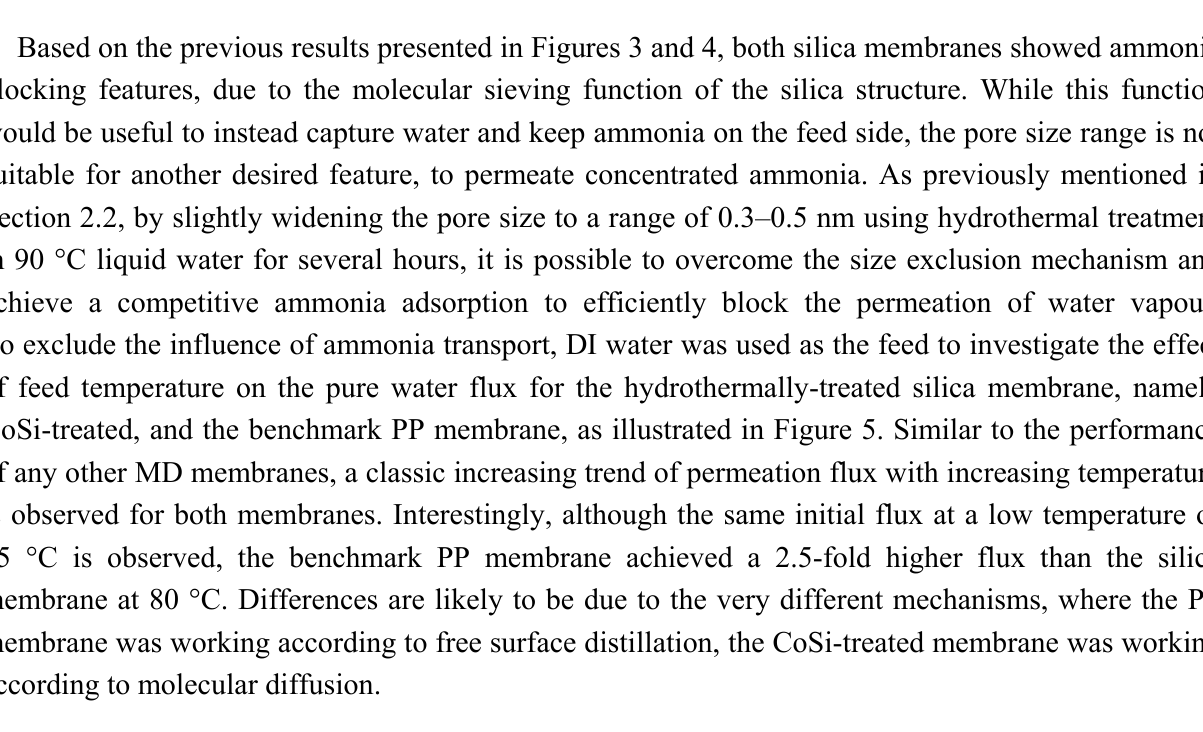
Figure 5. The effect of feed temperature on pure water flux for PP and CoSi-treated membranes [feed, deionized (DI) water; permeate absolute pressure, 100–150